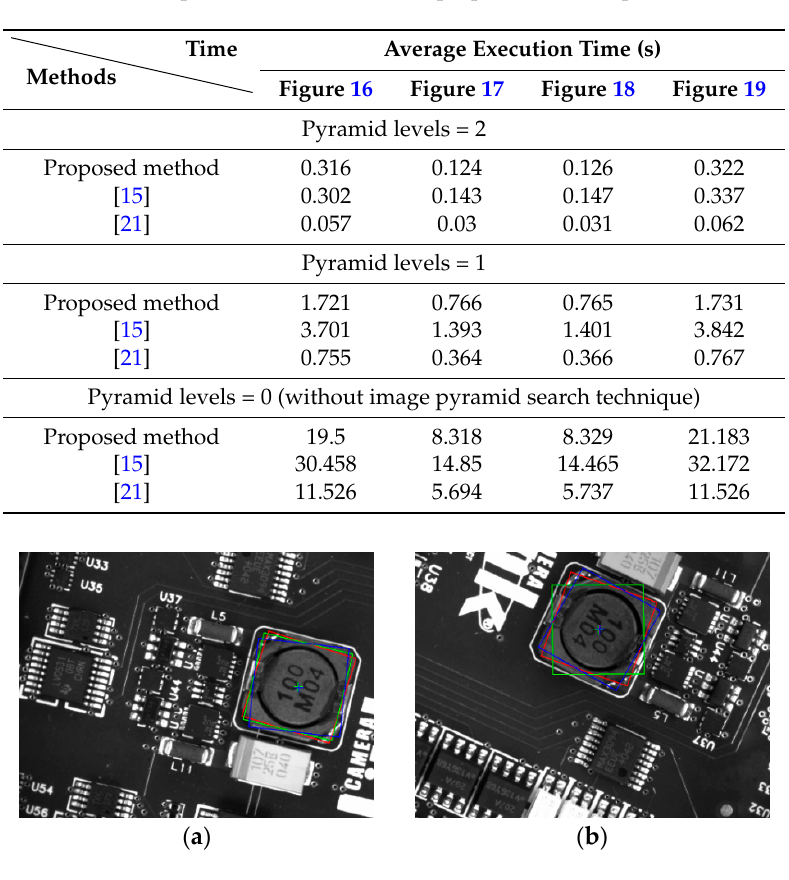
Figure 18. PCB case3 images. ( a – c ) real images and ( d ) template image (200 × 200 pixels). Table 5. The computational burden for the proposed and compared methods.